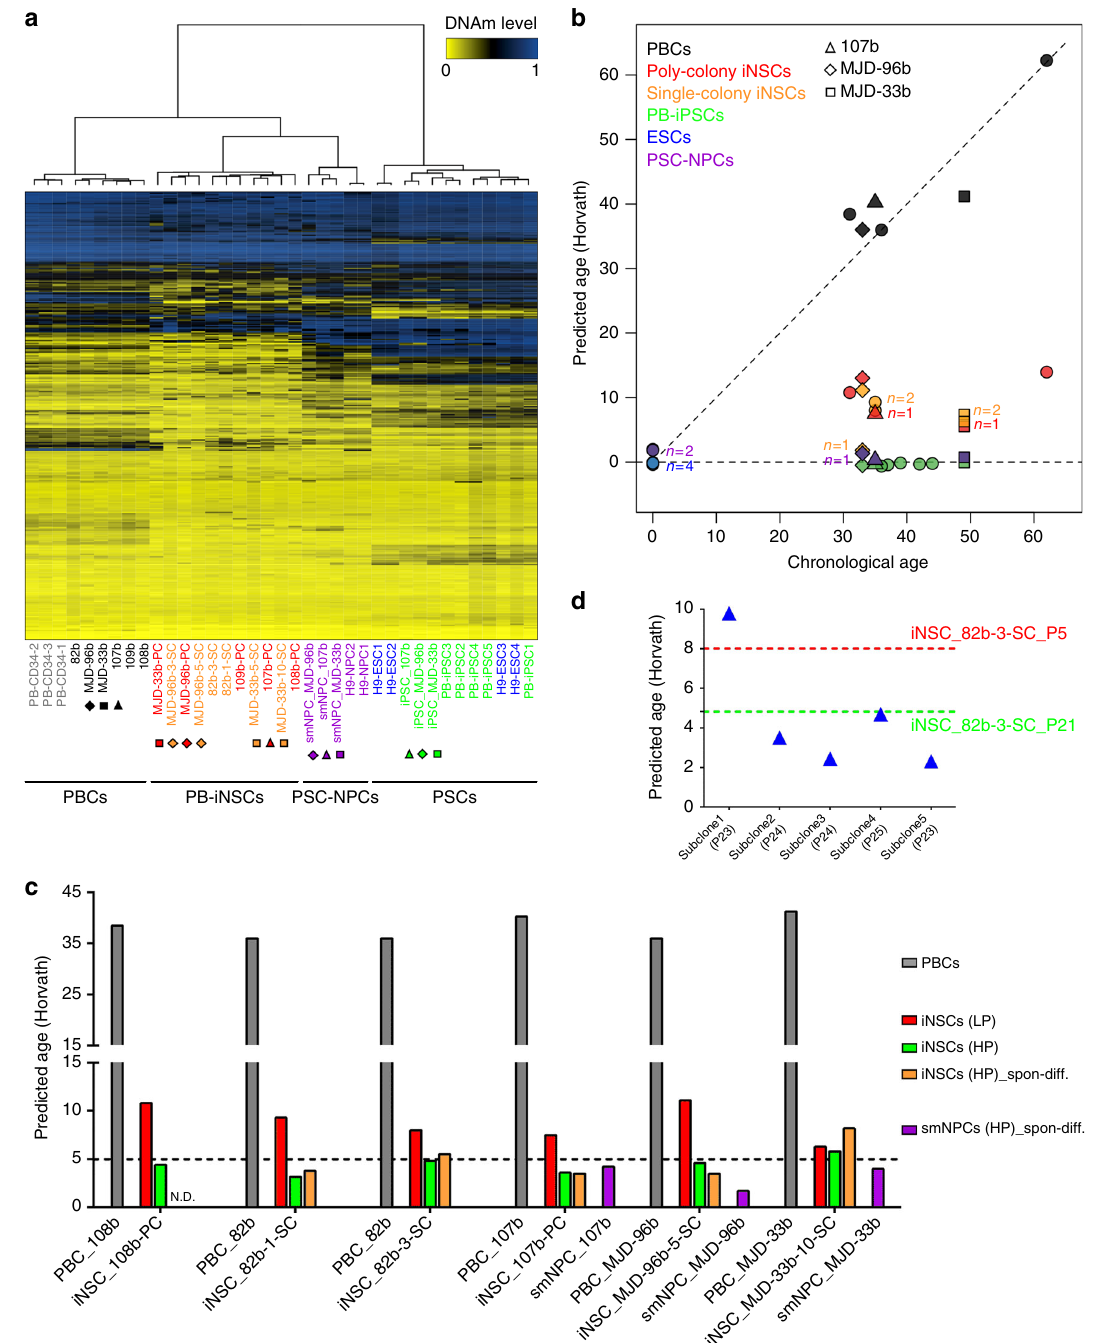
Fig. 5 Age-related epigenetic signatures of iNSCs and PSC-derived NPCs. a Heatmap representation of DNAm levels at the 353 age-associated CpG sites derived from the Horvath model. The age-associated DNAm patterns of iNSCs differ from PSCs. b Age prediction using the Horvath model. Poly- and single-colony-derived low passage iNSC cultures ( P ≤ 6) show a pronounced loss of age-related epigenetic signatures. Isogenic PB-iPSCs and iPSC-derived smNPCs display epigenetic age signatures similar to ESCs and ESC-derived NPCs. c Upon continuous expansion ( P ≥ 18), a further decline of predicted DNAm age is observed using the Horvath model in 6 independent iNSC lines. Spontaneously differentiated cultures derived from 5 high passage iNSC lines and 3 isogenic high passage smNPC lines ( P ≥ 18) show similar DNAm ages. d Subclones derived from single cells of a single-colony iNSC line (82b-3-SC) exhibit variable DNAm ages (Horvath model). N.D.: not